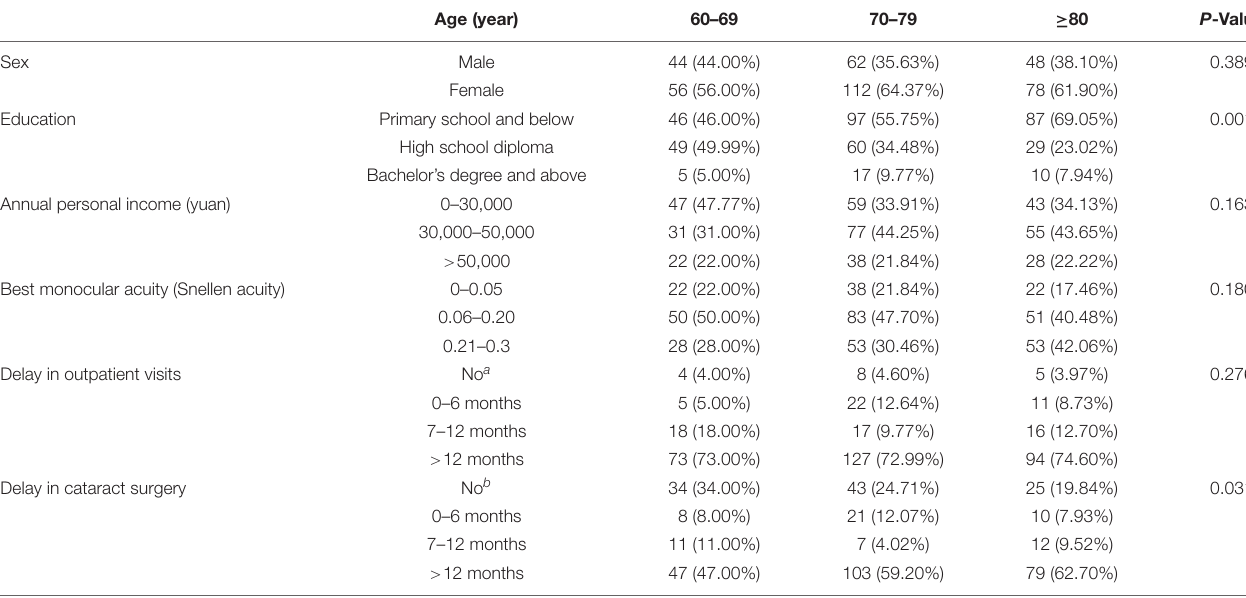
TABLE 1 | Demographic characteristics of the participants according to